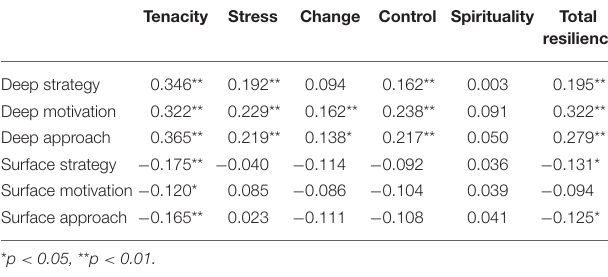
Table 2 | Bivariate correlations between Resilience and Learning Approaches.